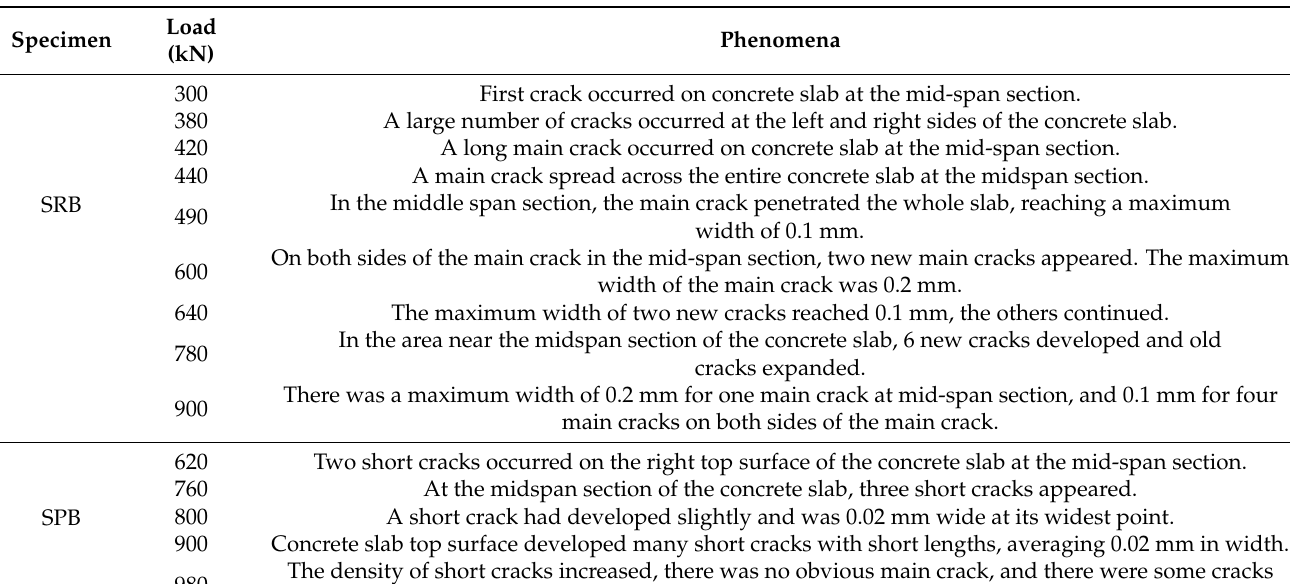
Table 4. Cracking of experimental